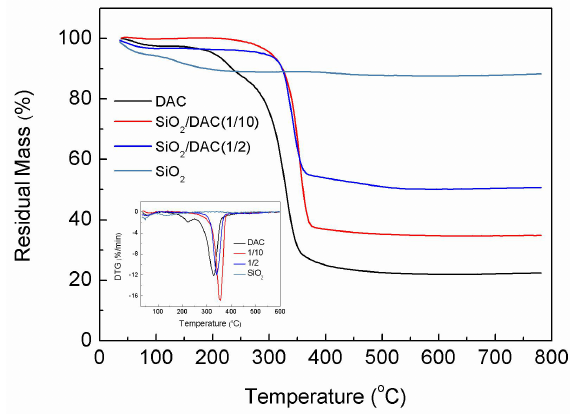
Figure 2. Thermogravimetric curves of the SiO 2 /DAC hybrid materials.